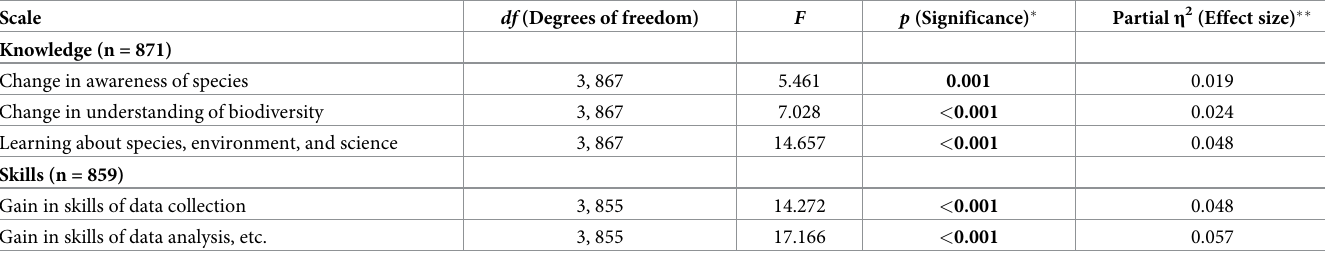
Table 9. Results of the one-way independent ANOVA test for the frequency of individual feedback received by project participants. Scale df (Degrees of freedom) F p (Significance) � Partial η 2 (Effect size)